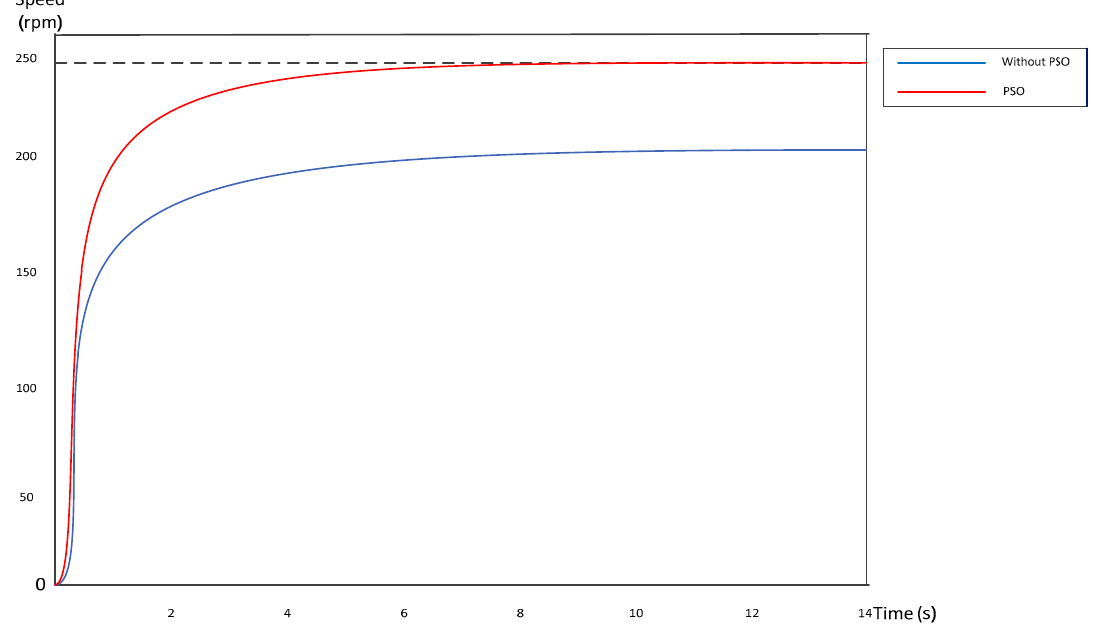
Figure 18. Characteristic curves of diesel engine speed control using PSO algorithms.